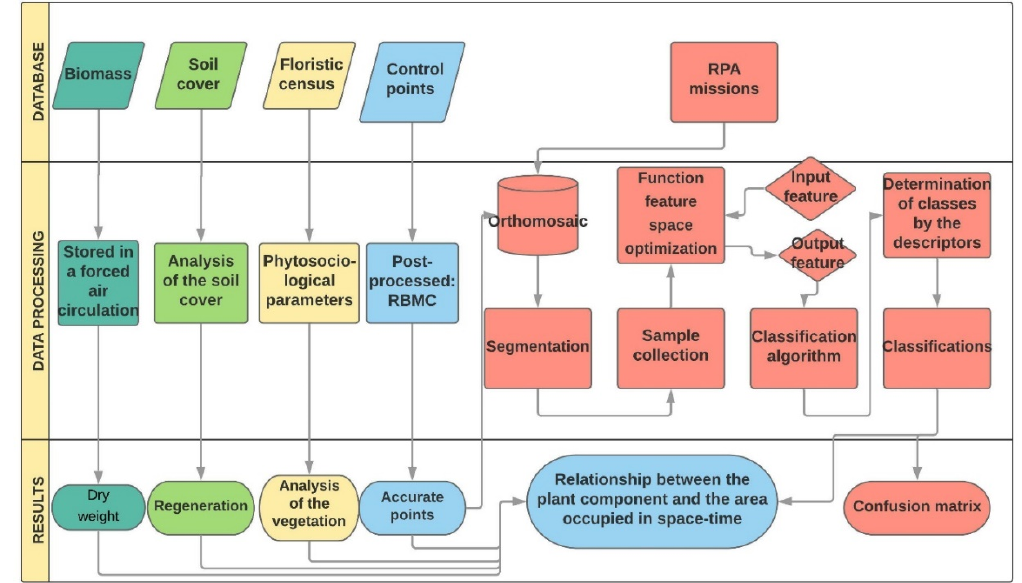
Figure 2. Flowchart of procedures performed in the study area.